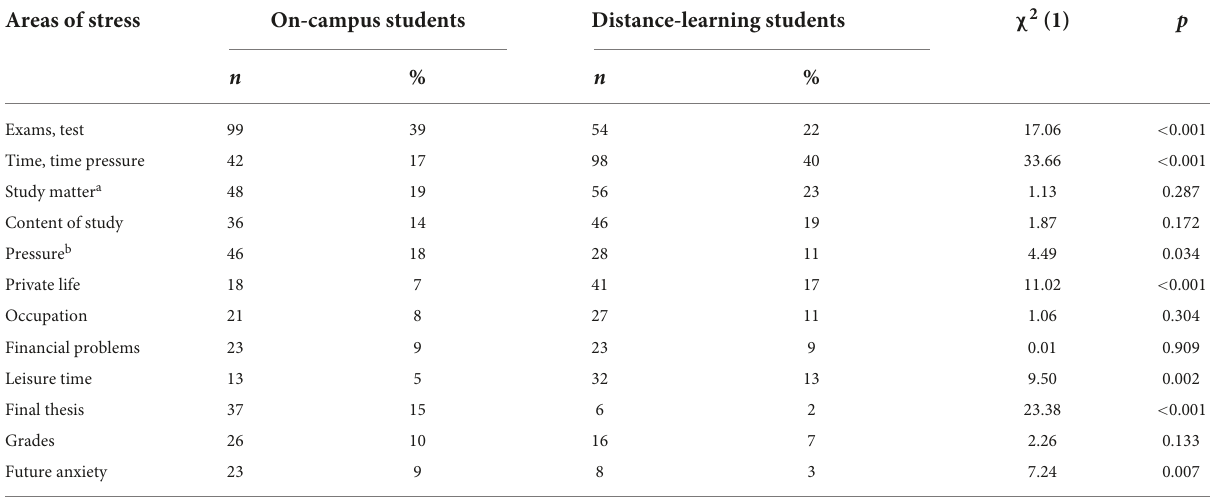
TABLE 4 Absolute (n) and relative (%) frequencies of areas of stress differentiated by on-campus students ( n = 254) and distance-learning students ( n = 246). Areas of stress